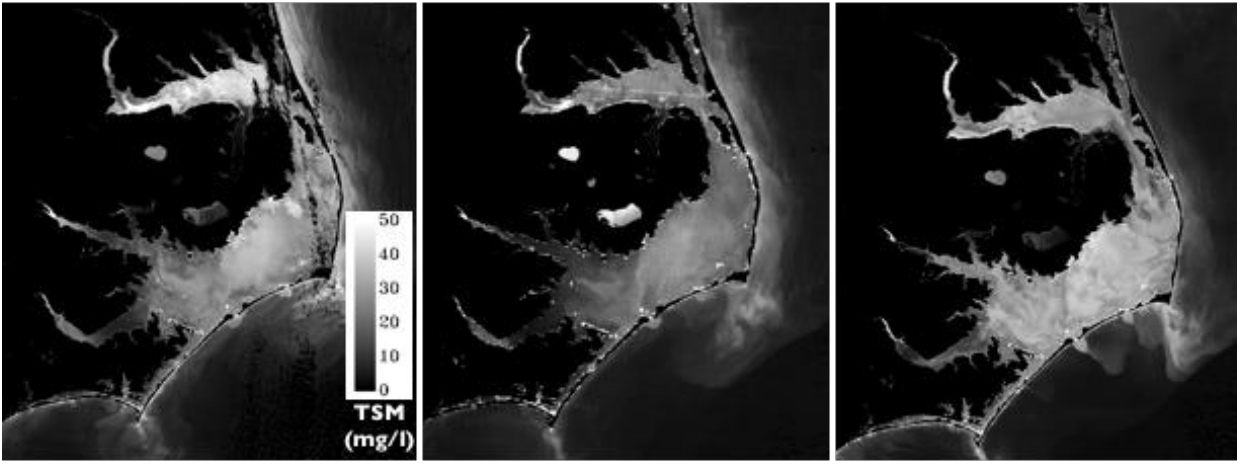
Figure 2. Images of Total Suspended Matter concentration (mg/L) of the APES derived from MODIS Terra 250 m data acquired on 7, 8, and 11 February 2010 (left to right) showing significant large-scale variation in TSM following the passage of a strong front that occurred over a short time period. Land and clouds are masked to black. From Miller and Buonassissi